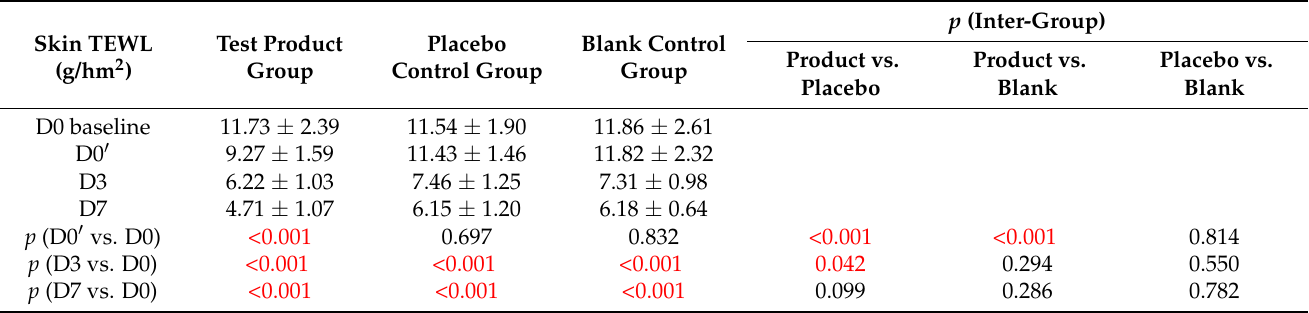
Table 1. Difference analysis of skin TEWL.